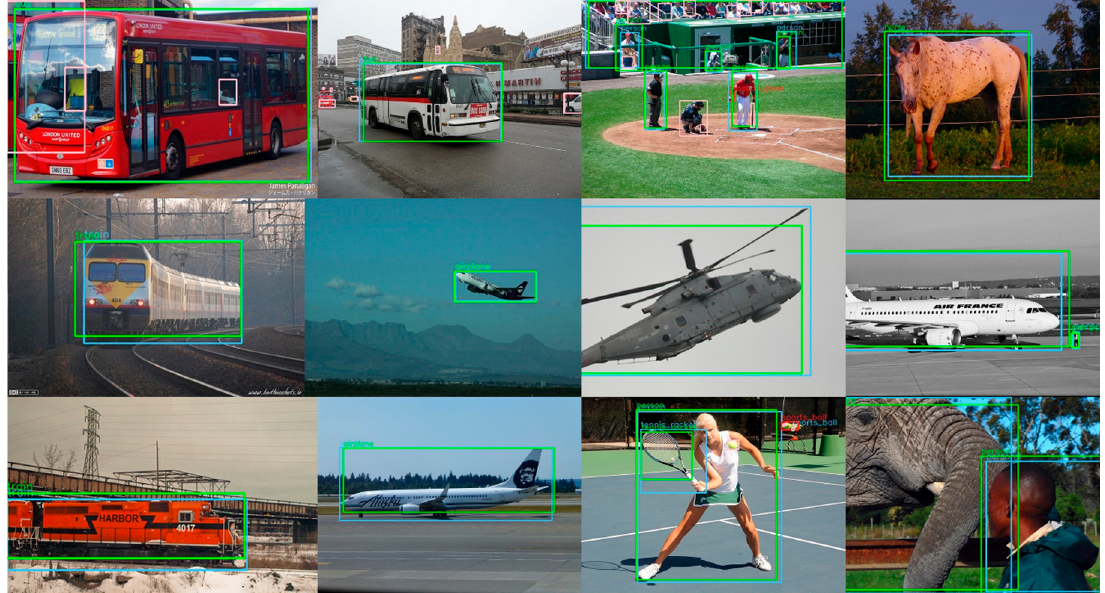
Figure 10. Several images that are successfully detected.